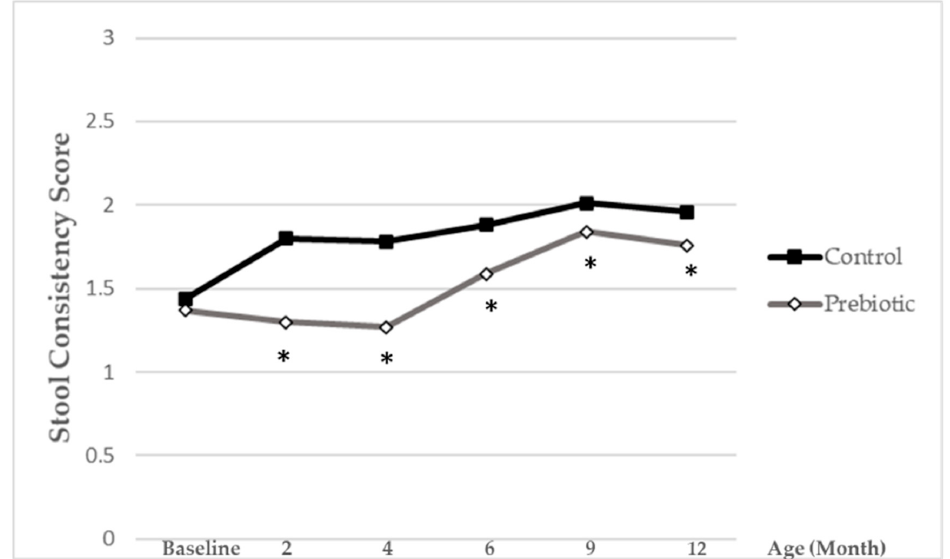
Figure 5. Mean stool consistency score for infants receiving prebiotic or control formula until 12 months of age. Grey lines containing white rhombs represent the prebiotic group, while black lines with black squares represent the control group. The lower score values reflect softer stools, while the higher ones reflect harder stools. * Statistically significant from control group ( p < 0.05).